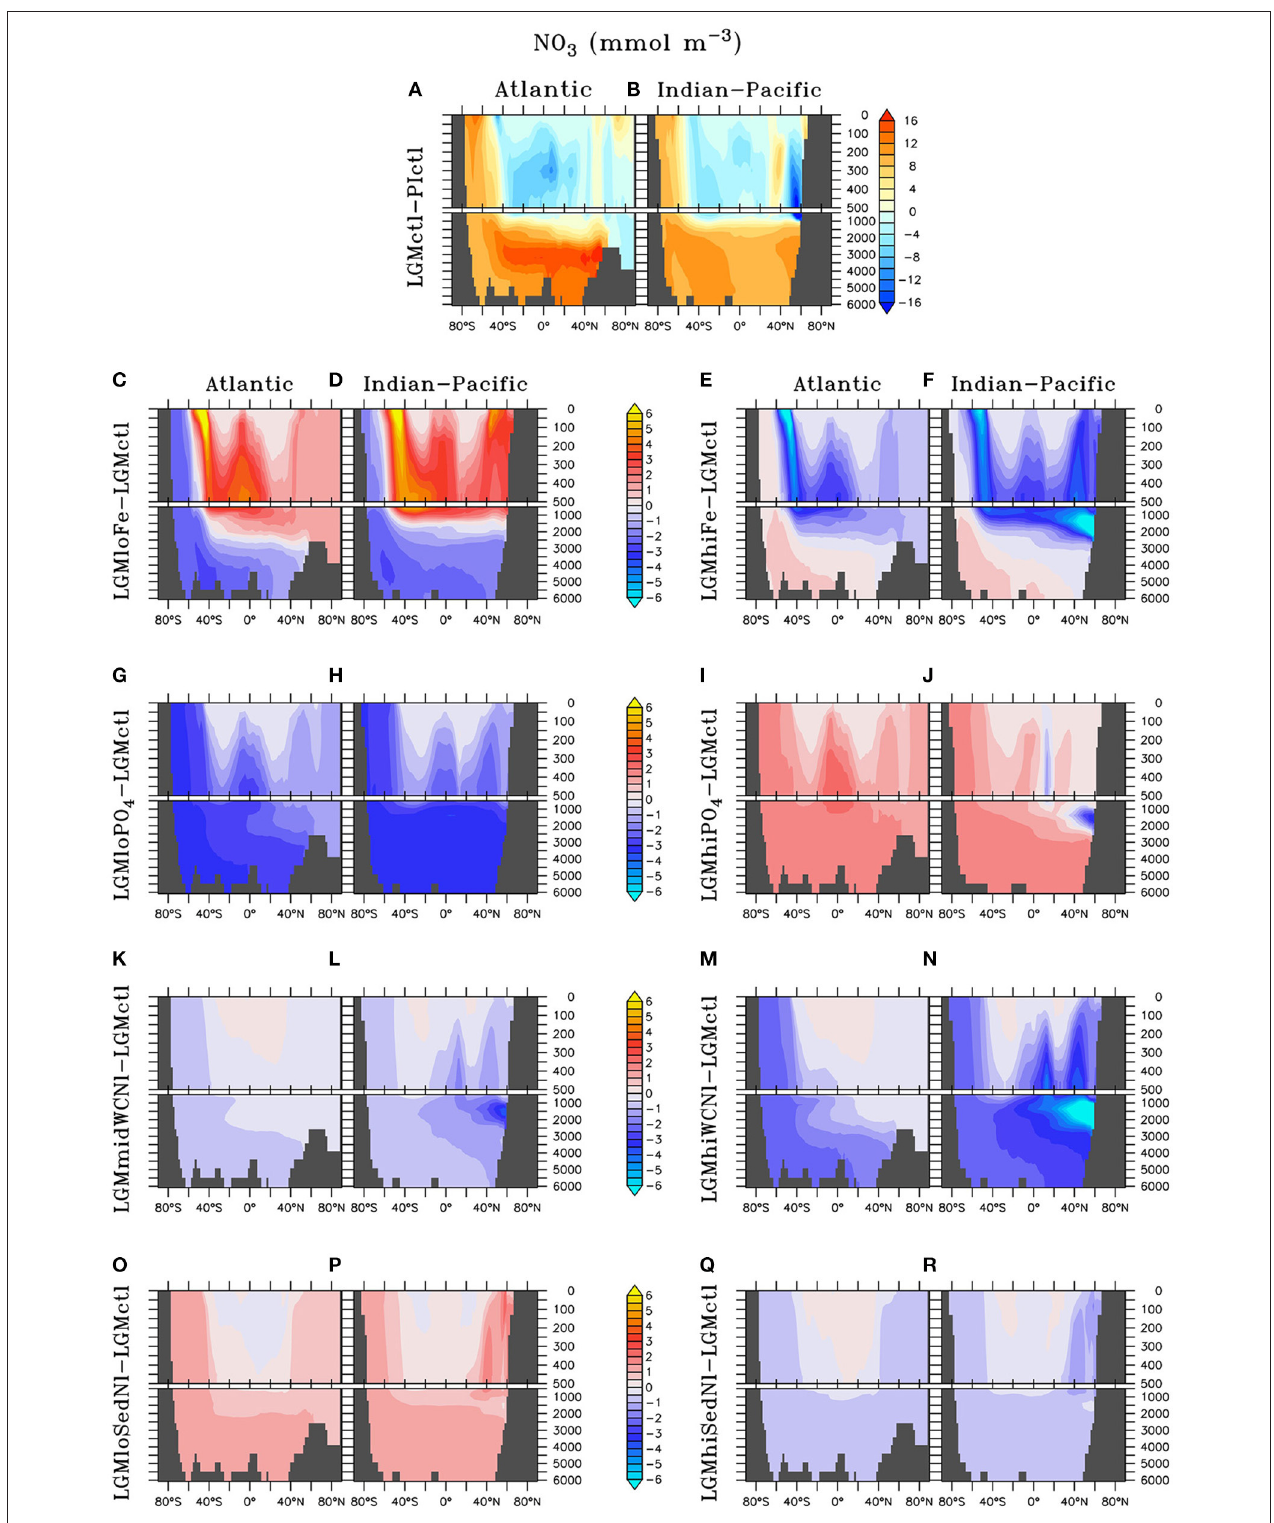
FIGURE 7 | Zonal dissolved nitrate (NO − 3 ) differences in the Atlantic and Indian-Pacific Oceans, respectively, of (A,B) Last glacial Maximum control (LGMctl) minus preindustrial control (PIctl) and the Last Glacial Maximum simulations minus LGM control: (C,D) LGMloFe, (E,F) LGMhiFe, (G,H) LGMloPO 3 − 4 , (I,J) LGMhiPO 3 − 4 , (K,L) LGMmidWCNl, (M,N) LGMhiWCNl, (O,P) LGMloSedNl, and (Q,R) LGMhiSedNl.